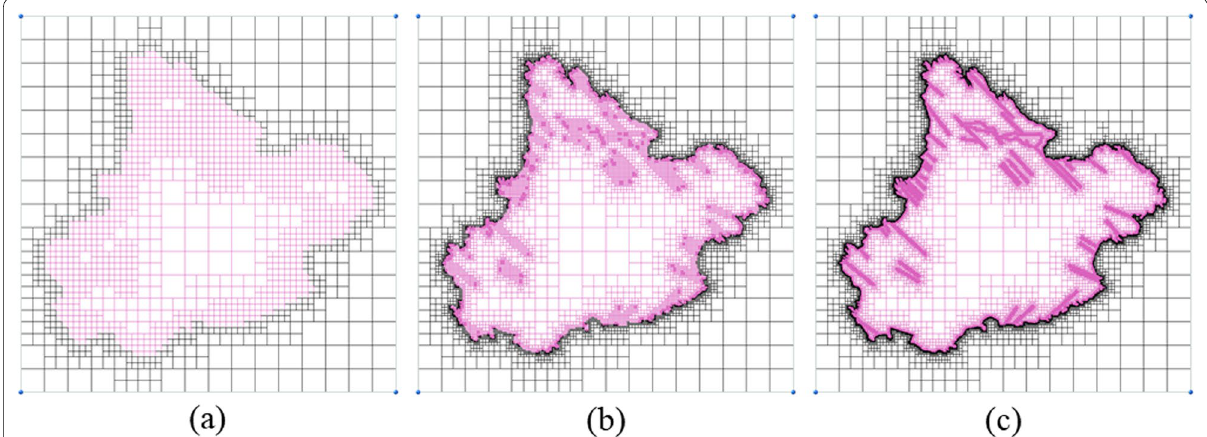
Fig. 8 Variation of meshing results with CRL max : a CRL max = 5 with 63,309 cells, b CRL max = 8 with 3,964,003 cells, c CRL max = 10 with 51,258,089